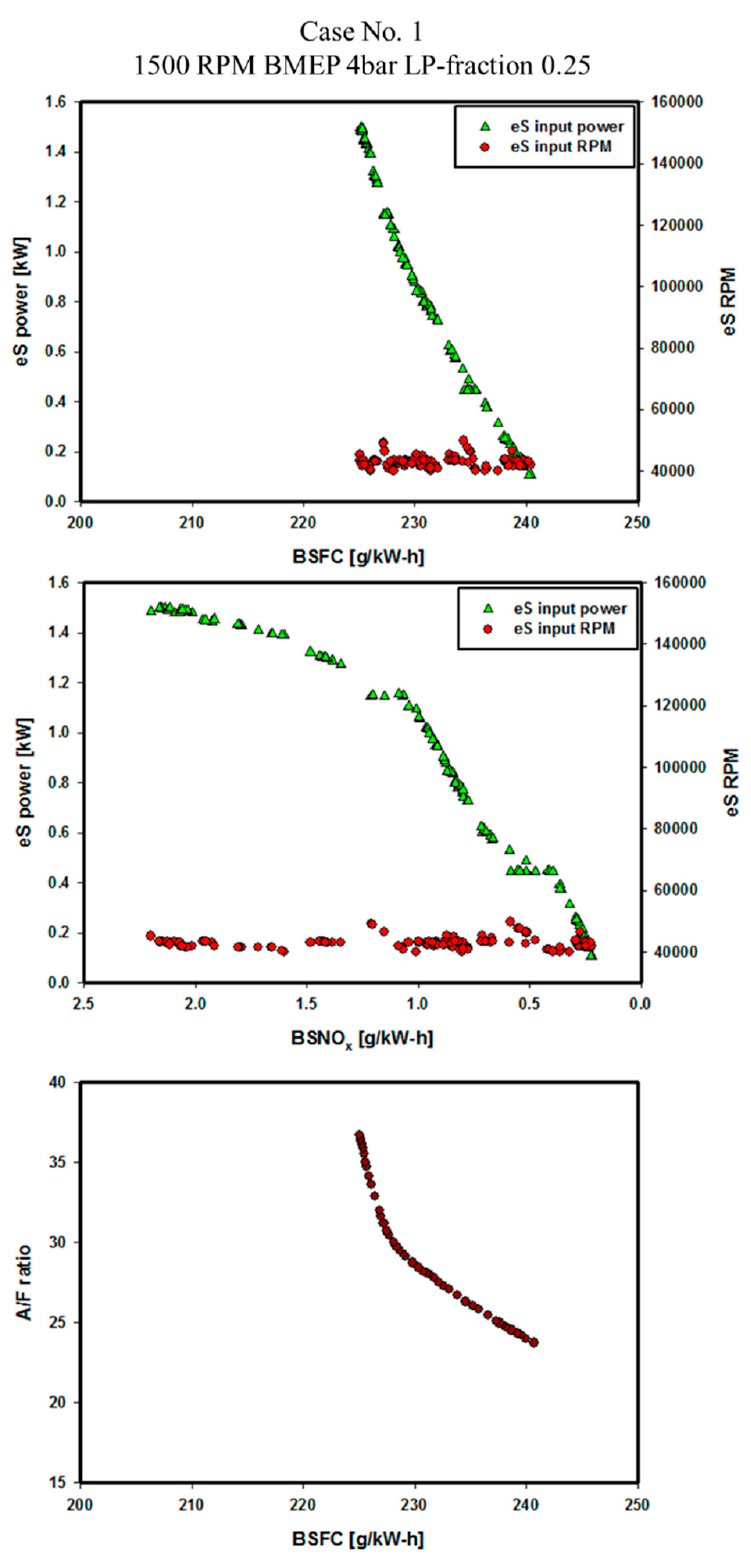
Figure 12. BSFC, BSNO x , and A/F ratio differences on the Pareto front line of case 1 (LP fraction = 0.25).